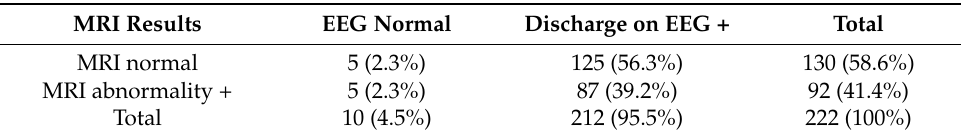
Table 1. Magnetic resonance imaging (MRI) and electroencephalography (EEG) findings classified as normal and abnormal.